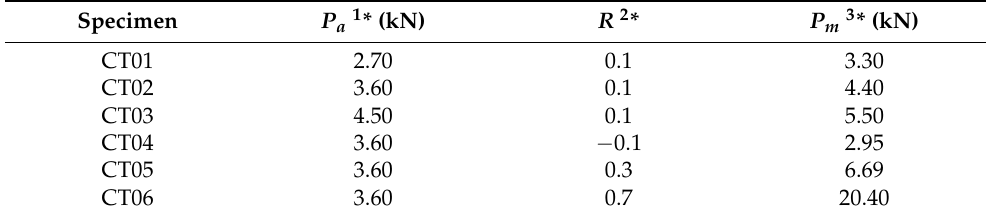
Table 2. Crack propagation experiment loading conditions of CT